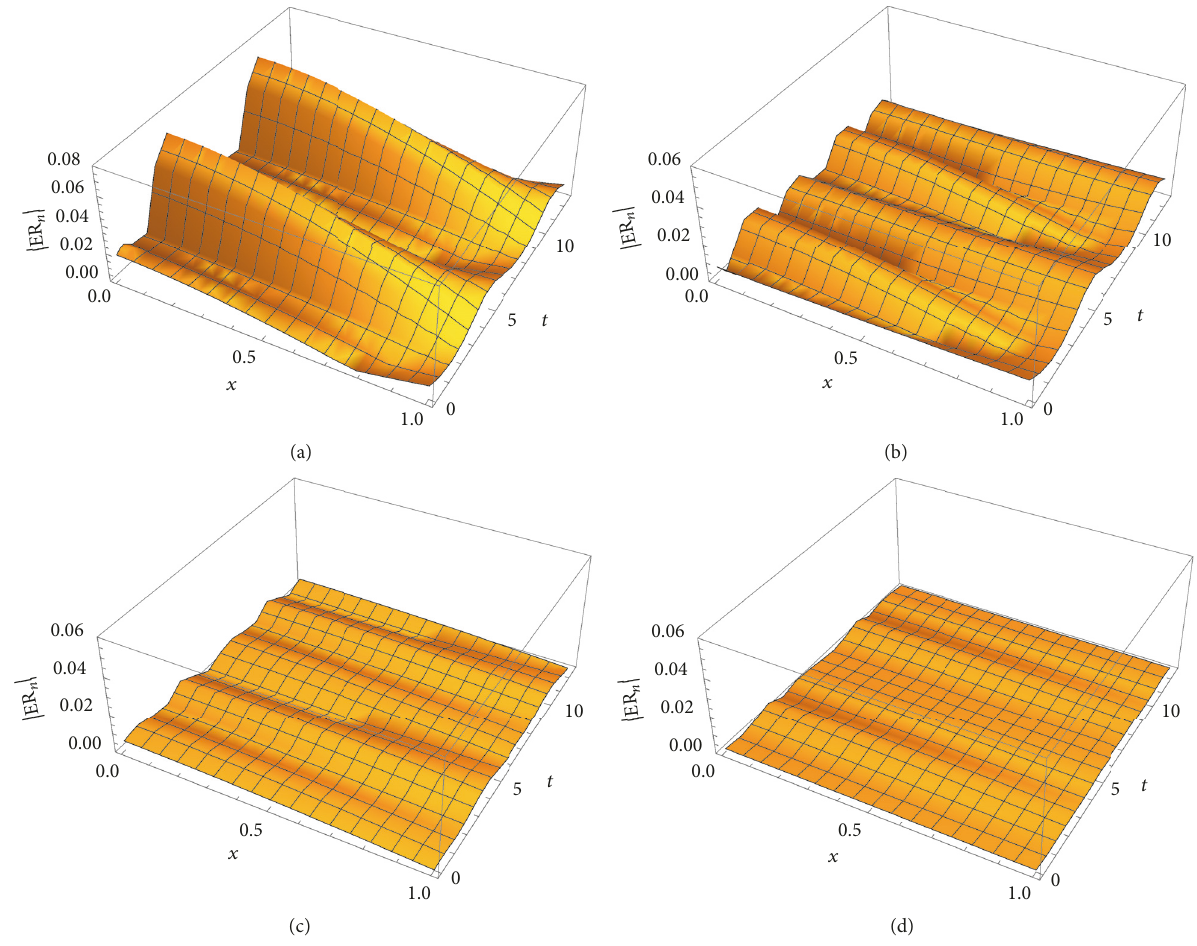
Figure 5: Surfaces of the absolute error remainder functions for 𝛼 = 1.8 , (a) | ER 2 (𝑥,𝑡)| , (b) | ER 3 (𝑥,𝑡)| , (c) | ER 4 (𝑥,𝑡)| , and (d) | ER 5 (𝑥, 𝑡)| .